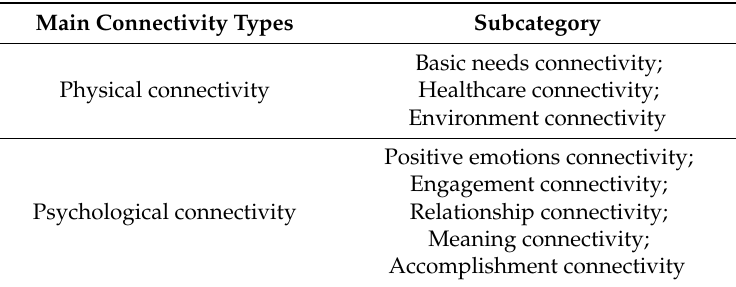
Table 1. The types of connectivity need of new